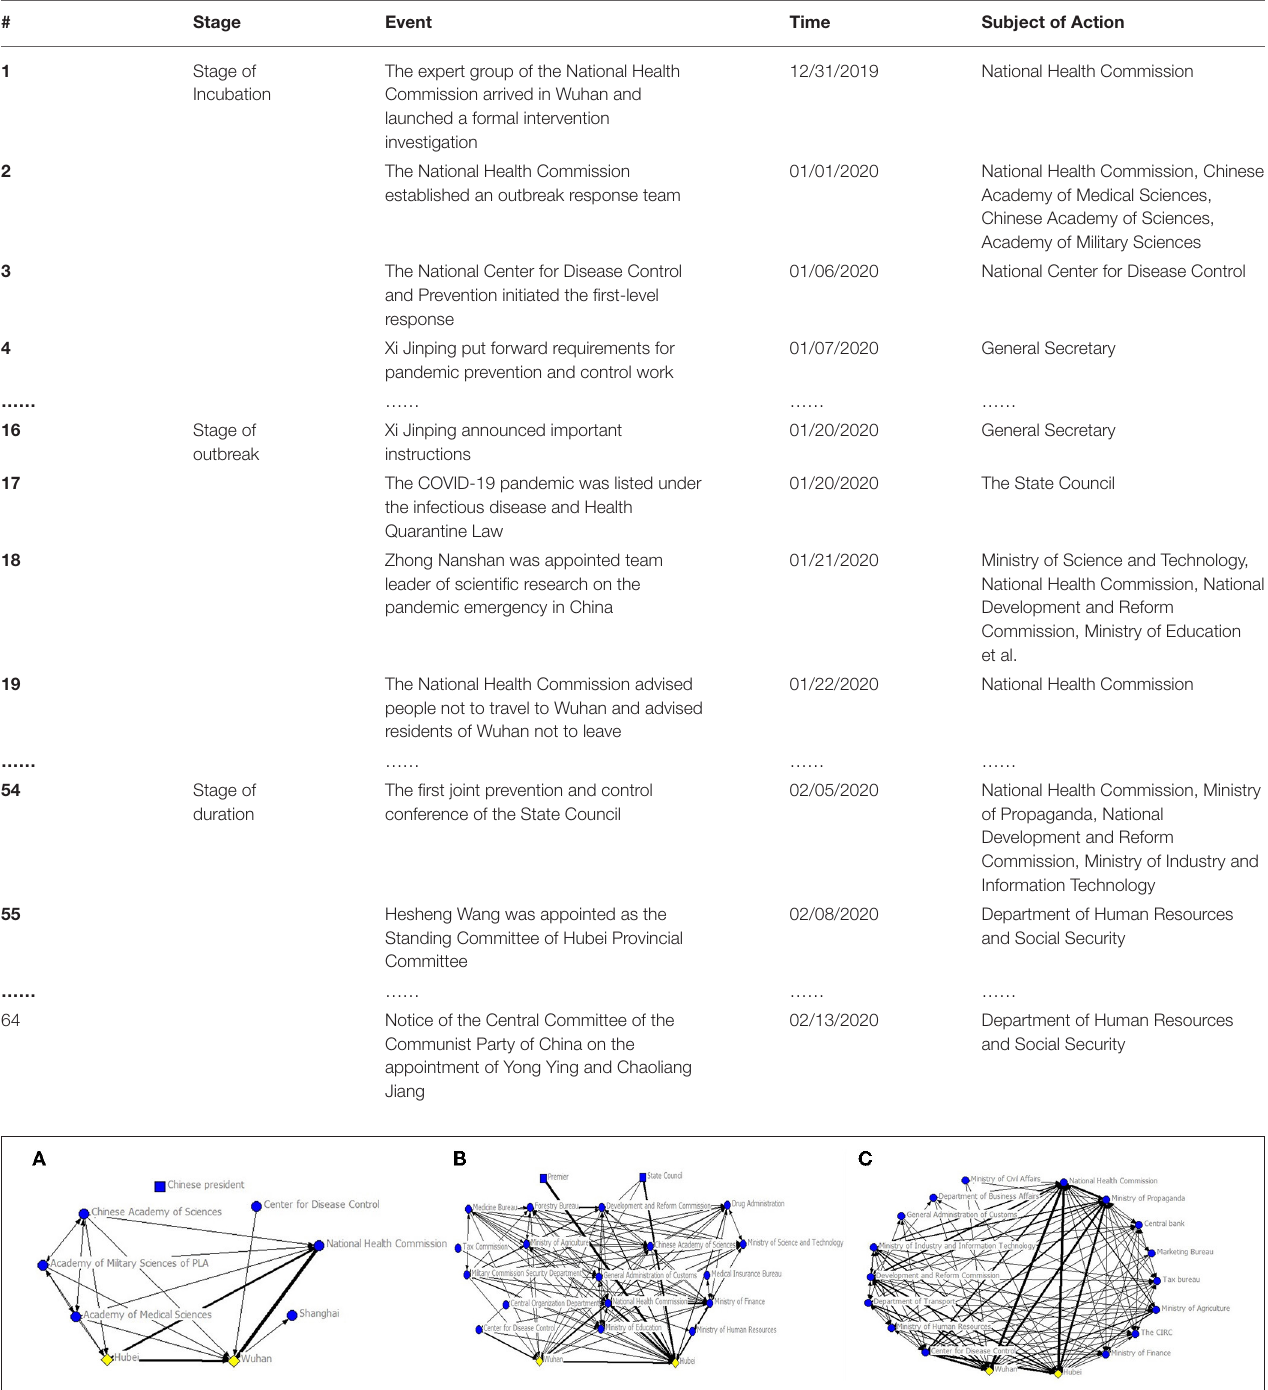
TABLE 1 | Important events related to the Central Government’s response in the COVID-19 pandemic.